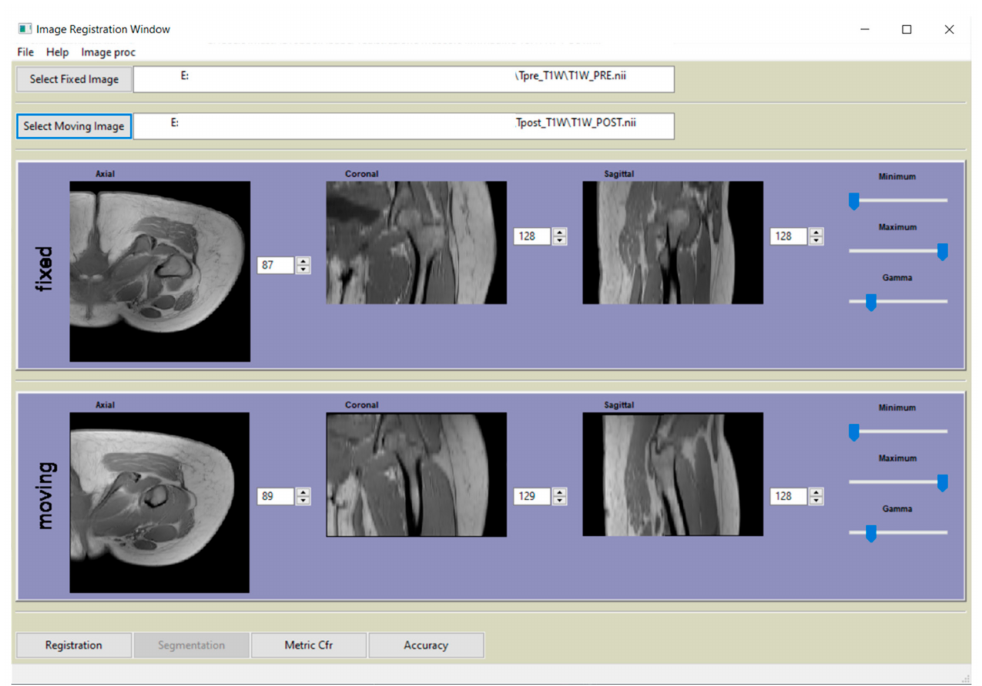
Figure 3. Main window of the graphical user interface (GUI) of the software, developed in Python, that complement the paper.